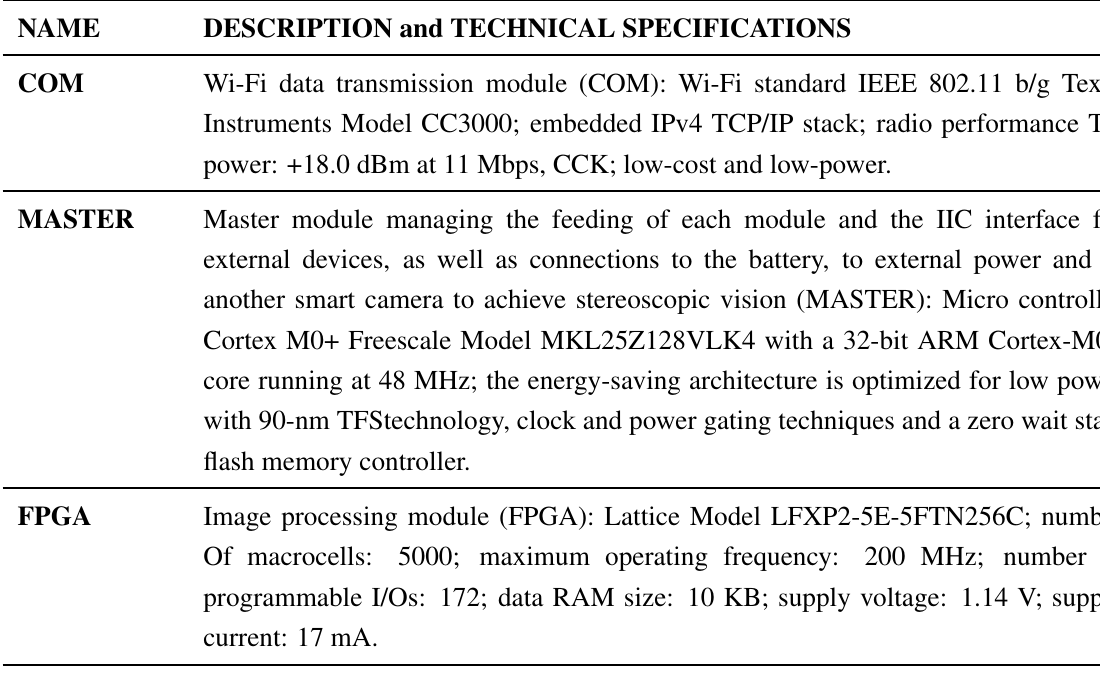
Figure 2. Diagram of the five components with their input/output connections. Table 1. Description of each module of the smart